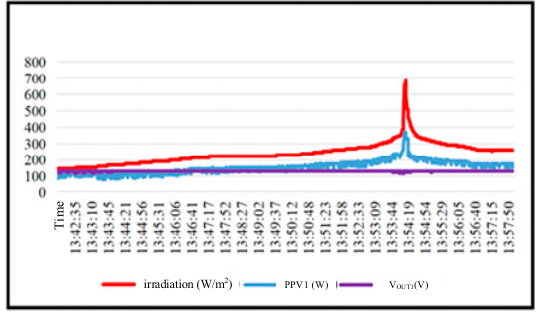
Figure 19. Irradiation vs. solar panel power and voltage.